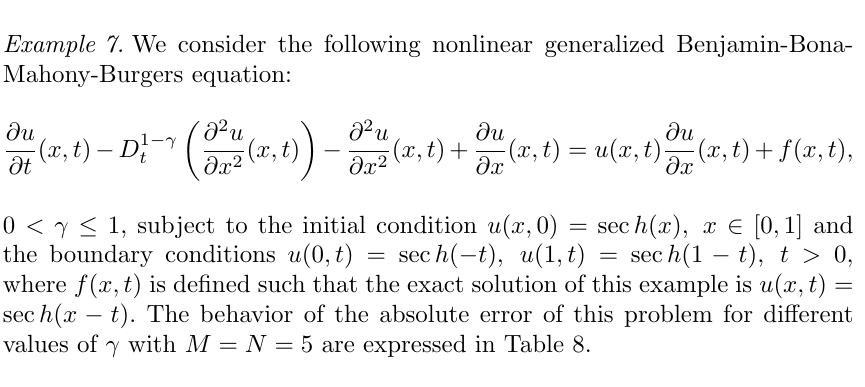
Table 8. Absolute errors for various values of γ with β = 1 and M = N = 5 on the interval [0 , 1] × [0 , 1] for Example 7. x = t γ = 0 . 8 γ = 0 . 85 γ = 0 . 9 γ = 0 . 95 γ = 1 0 0 0 0 0 0 0 . 1 2 . 7218 × 10 − 6 2 . 2850 × 10 − 6 1 . 8066 × 10 − 6 1 . 2749 × 10 − 6 6 . 7496 × 10 − 7 0 . 3 1 . 6089 × 10 − 5 1 . 3164 × 10 − 5 9 . 9425 × 10 − 6 6 . 3449 × 10 − 6 2 . 2667 × 10 − 6 0 . 5 3 . 0084 × 10 − 5 2 . 4436 × 10 − 5 1 . 8196 × 10 − 5 1 . 1211 × 10 − 5 3 . 2766 × 10 − 6 0 . 7 3 . 7621 × 10 − 5 3 . 1051 × 10 − 5 2 . 3785 × 10 − 5 1 . 5645 × 10 − 5 6 . 3977 × 10 − 6 0 . 9 2 . 4285 × 10 − 5 2 . 0655 × 10 − 5 1 . 6640 × 10 − 5 1 . 2144 × 10 − 5 7 . 0420 × 10 − 6 1 0 0 0 0